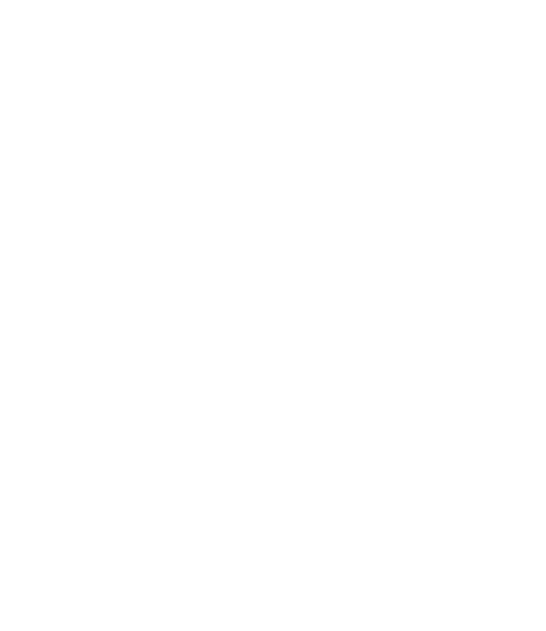
FIGUREA3 | Effect of memantine on pre-synaptic probability of release. (A – C) Time-course of MK-801 (5 µ M) induced reduction of the NMDAR current amplitude in PCs ( n = 8) and Ints ( n = 7), respectively. NMDAR currents were recorded from individual PCs and Ints voltage-clamped at V m =− 70mV. (B,D) Time-course of MK-801 (5 µ M) + memantine (10 µ M) induced reduction